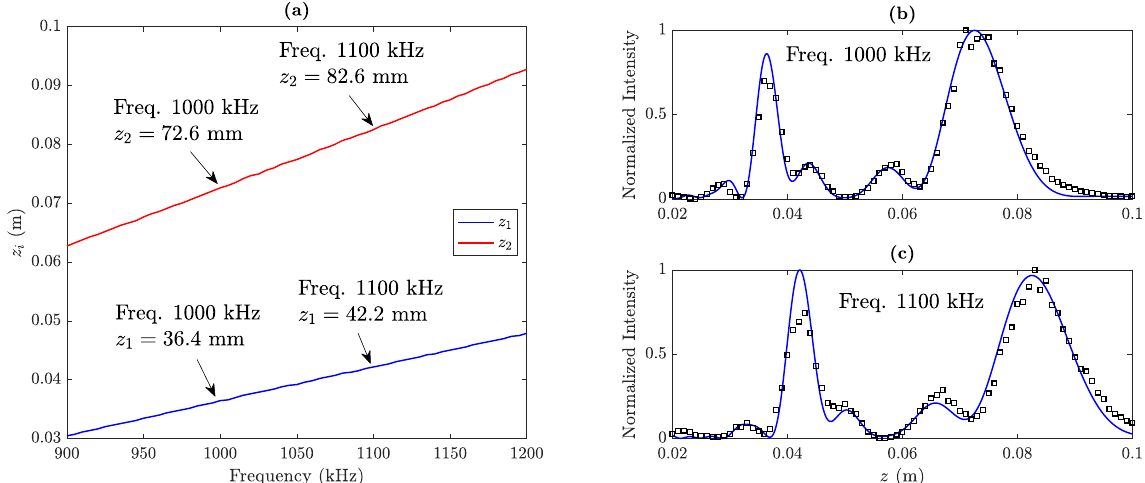
Figure 9. ( a ) Numerically computed focal distances as a function of the working frequency; Experimental (black squares) and simulated (blue line) focusing profiles at ( b ) 1 MHz and ( c ) 1.1